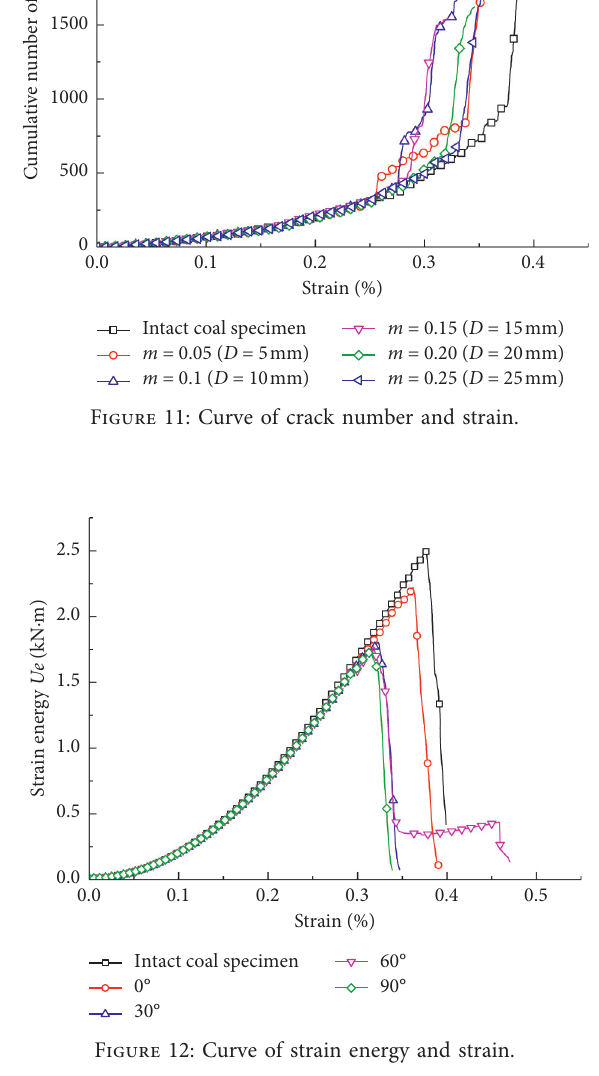
Figure 10: Curve of dissipated energy and strain.